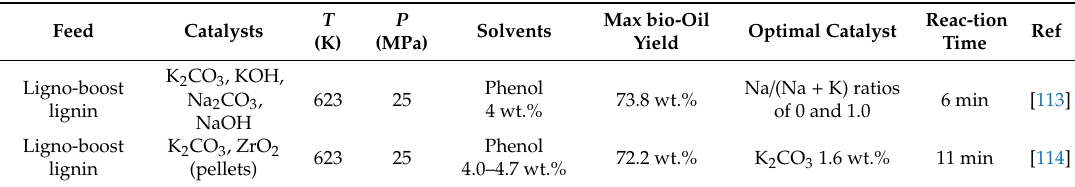
Table 8. E ff ects of various catalyst